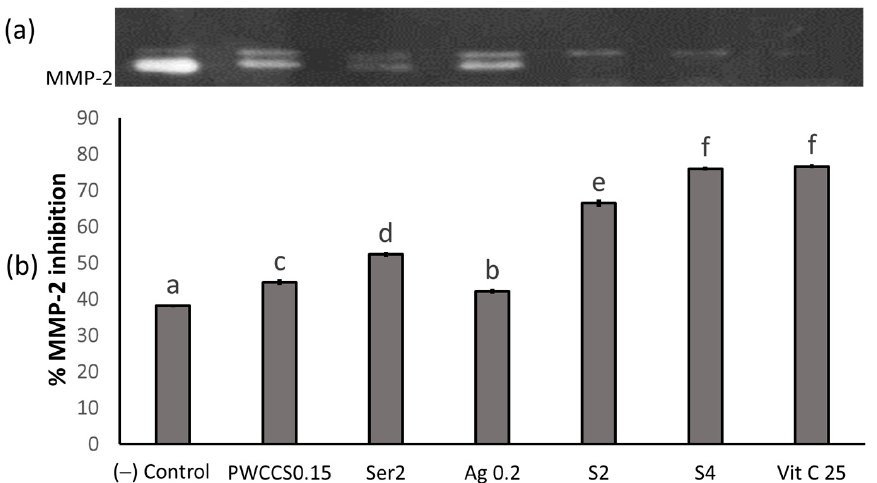
Figure 12. MMP-2 expression by the zymography detection content of 0.15% PWCCS(PWCCS0.15), 2% sericin (Ser2), 0.2% alginate (Ag0.2), 25 µ g/mL ascorbic acid (Vit C), S2, and S4 treated on the NHDF cells after 24 h. ( a ) MMP-2 zymography bands; ( b ) MMP-2 inhibition analyzed the band intensity by the image J analysis. Data represent the mean ± SEM of the three replicates. Statistical significance was evaluated by Duncan’s post-hoc test; a–f letters indicate significant differences between the group at p < 0.05.